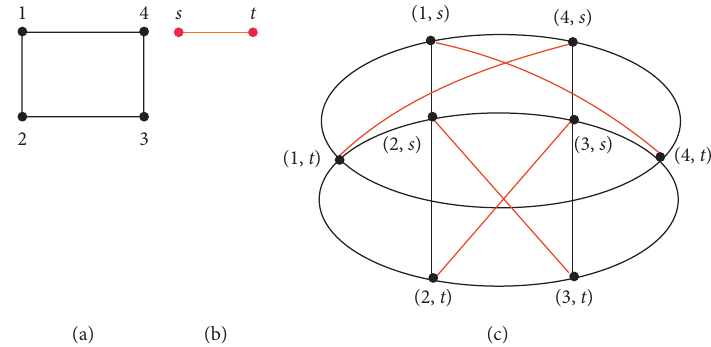
� P , and (c) fence ( P 2 2